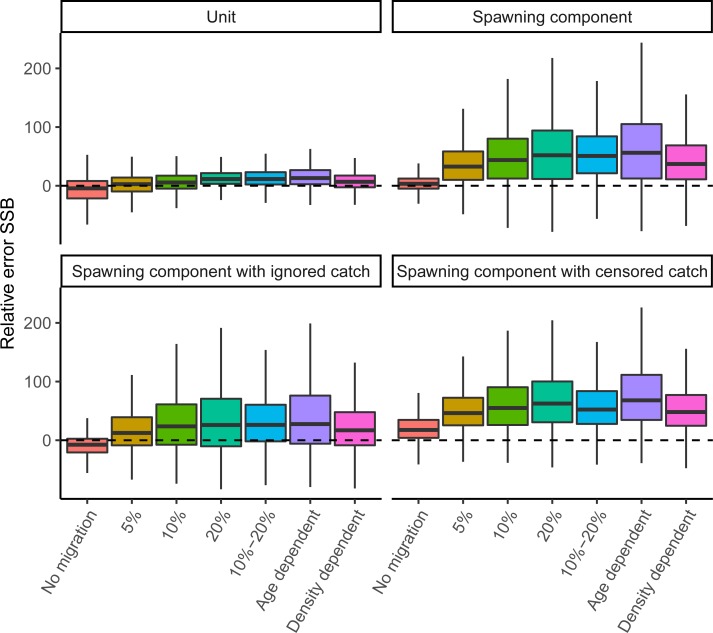
Boxplots of relative error (RE, %) in SSB by the four standard estimations models (panels) based on pseud-data generated by seven operating models (Table 2).The dashed line indicates zero or no error.